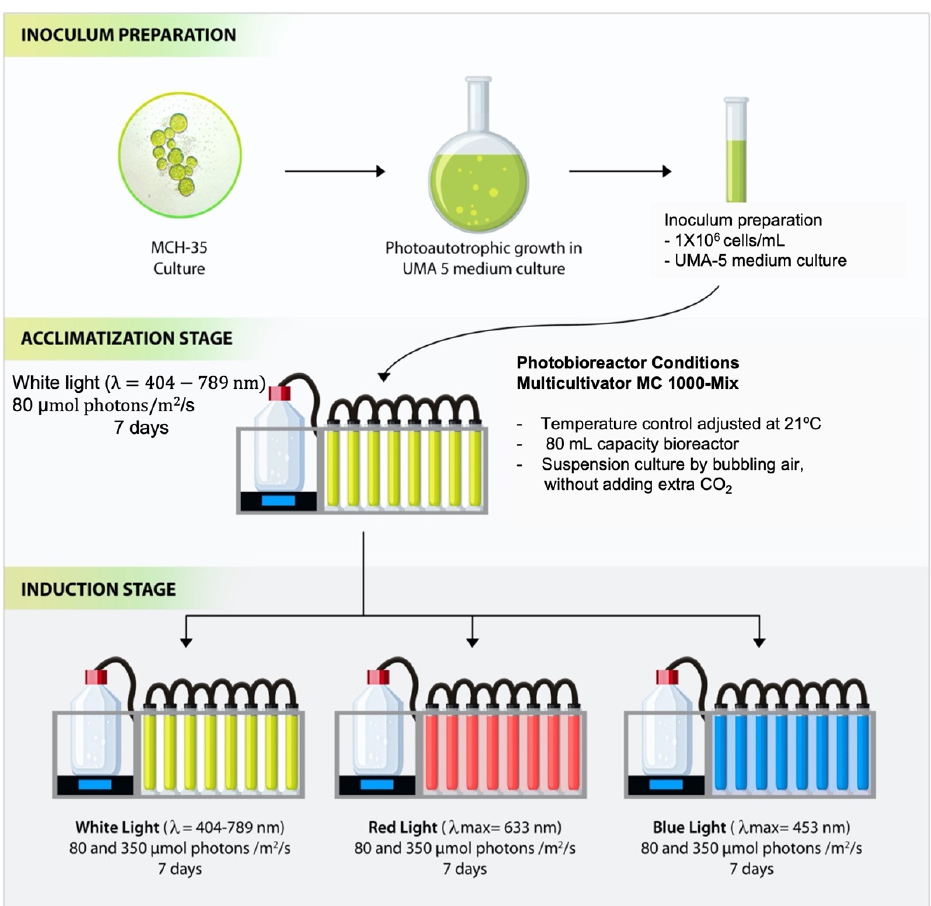
Figure 7. Descriptive two-stage model for the culture conditions of the MCH-35 microalgae grown under different light wavelengths (red, blue, and white) and irradiances (80 µmol photons/m 2 /s and 350 µmol photons/m 2 /s).